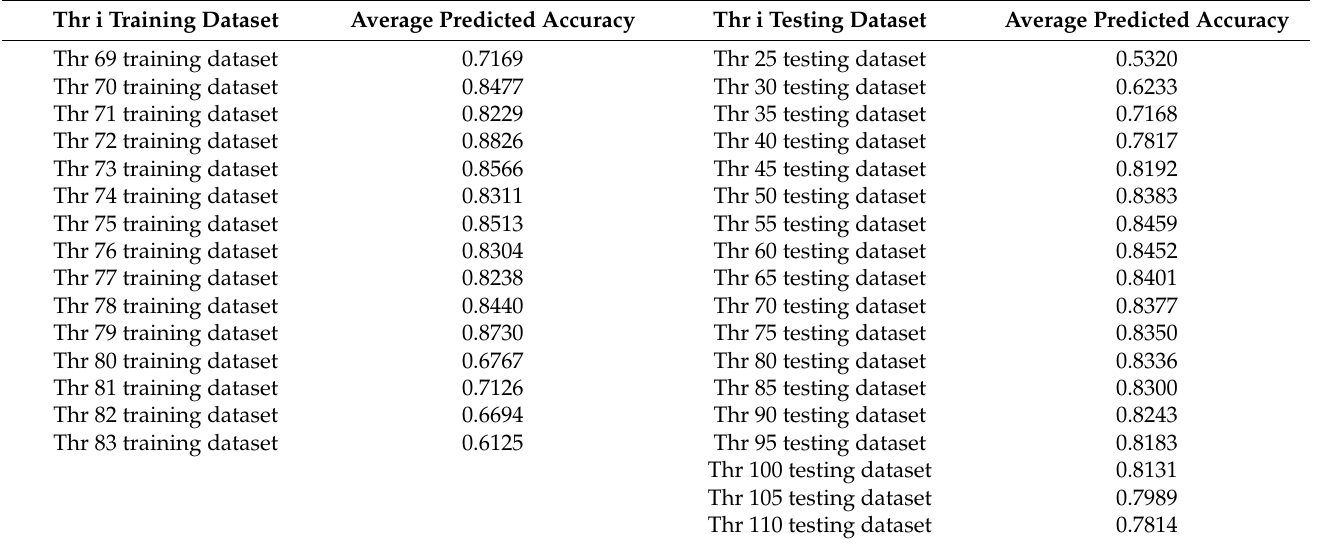
Table 4. Average prediction accuracy per Thr training dataset and Thr testing